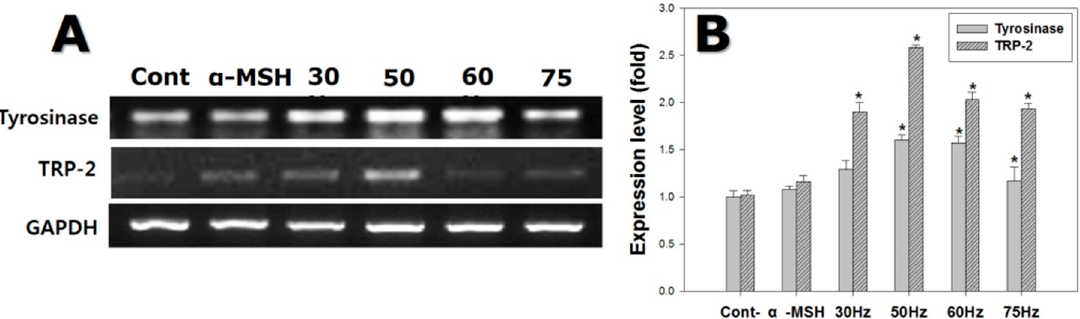
Figure 5. Gene expression detected by reverse transcription polymerase chain reaction (RT-PCR) on melanocytes after exposure to extremely low frequency electromagnetic fields for 72 h. ( A ) Electrophoretic RT-PCR for melanogenesis-related genes; ( B ) mRNA expression of melanogenesis-related genes, using glyceraldehyde-3-phosphate dehydrogenase ( GAPDH ) as the reference protein. Each bar represents the mean ± standard error of independent experiments performed in triplicate ( n = 5). * p < 0.05, compared to the control (Cont).